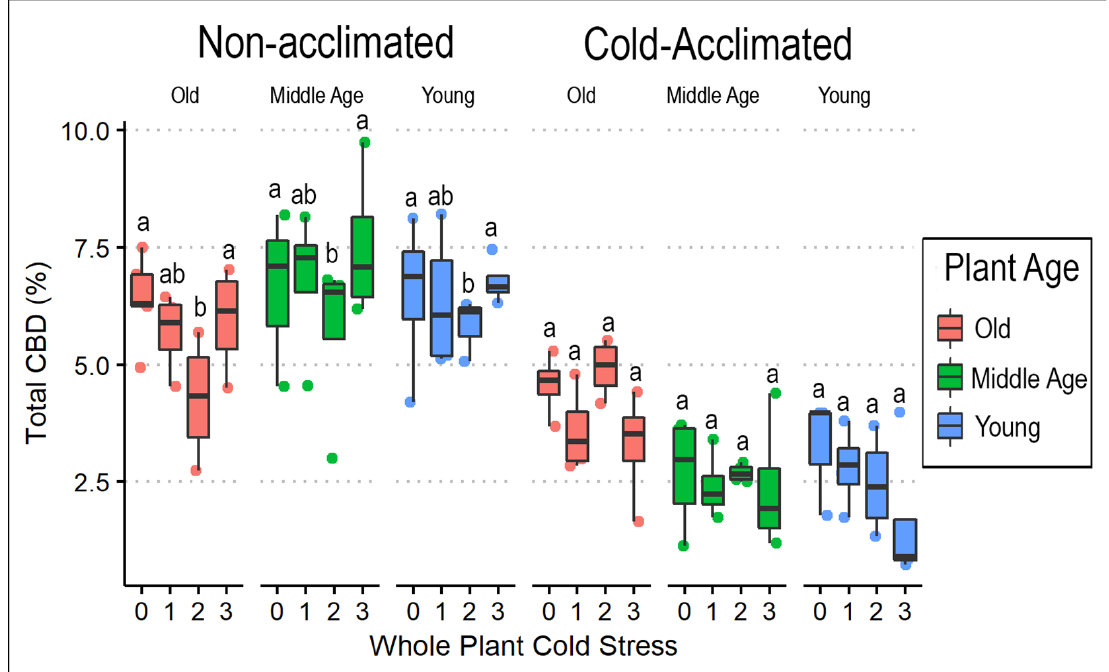
Figure 6. Total CBD (%) box plot comparing whole-plant cold stress to acclimation treatment and plant age in ‘AutoCBD’. Data represent the percentage of CBD’s neutral form added to the product of the percentage of CBD acid form multiplied by the cannabinoid’s molecular weight (0.877). Plants receiving cold acclimation treatment were subject to 10 days at 10 °C. Whole-plant cold stress consisted of a control treatment receiving no cold exposure, 0 (control); a single 3 h − 0.5 °C exposure, 1 ; two consecutive 3 h − 0.5 °C exposures separated by 24 h, 2 ; and three 3 h − 0.5 °C exposures separated by 24 h, 3 . Plant age treatments include oldest plants, middle-age plants, and youngest plants (68, 54, and 40 days old on the day of whole-plant cold stress, respectively). Lowercase letters indicate significant differences ( p < 0.05) between treatments (Tukey’s test).